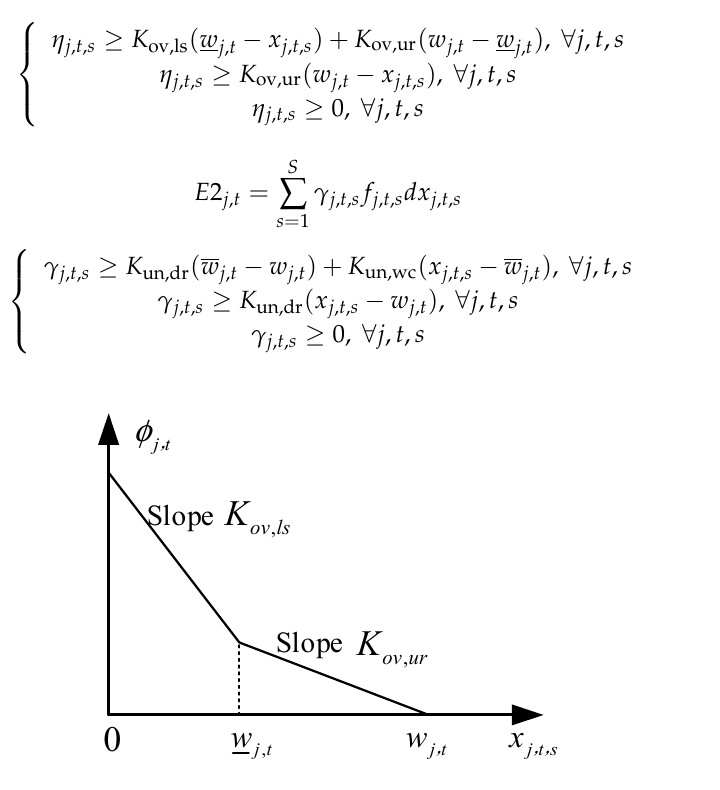
Figure 5. Function image of ϕ j,t.